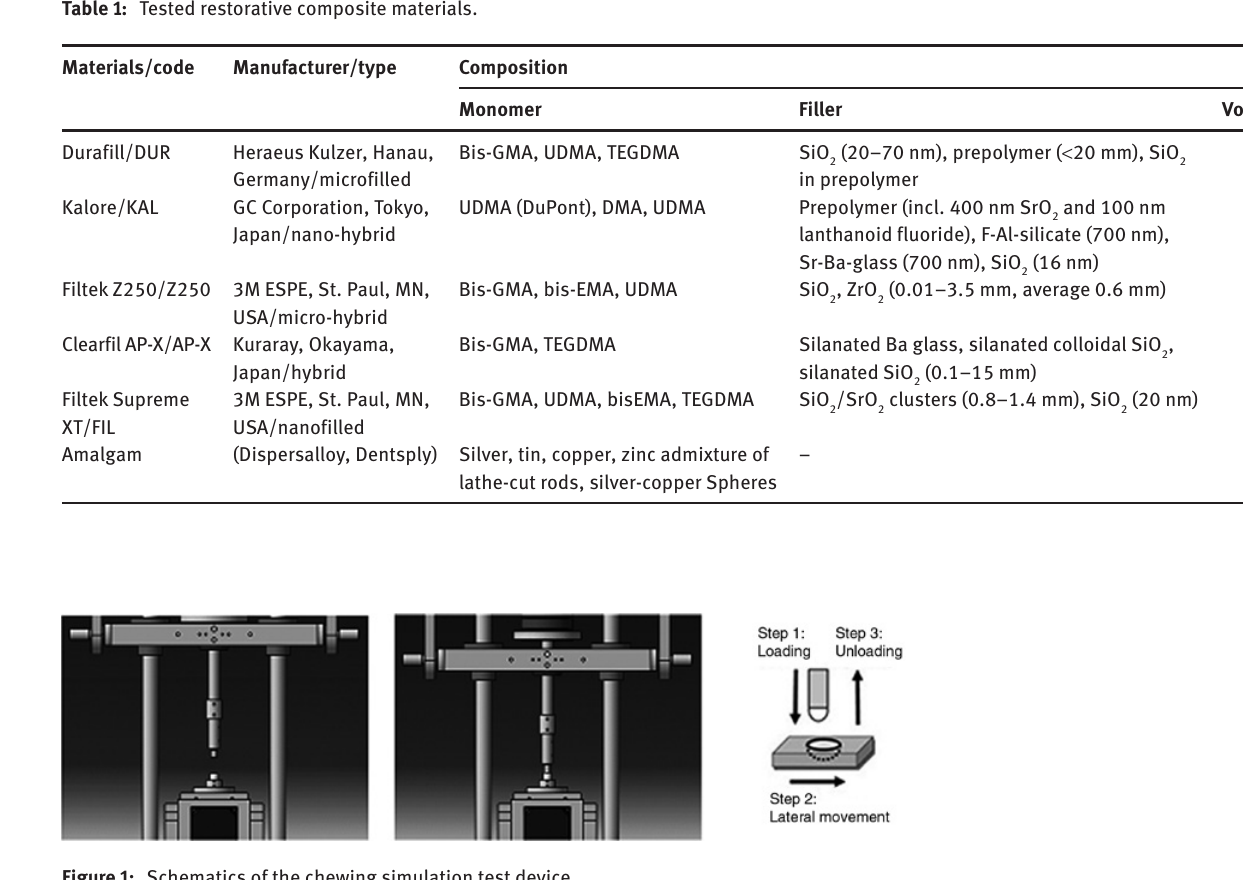
Figure 1: Schematics of the chewing simulation test